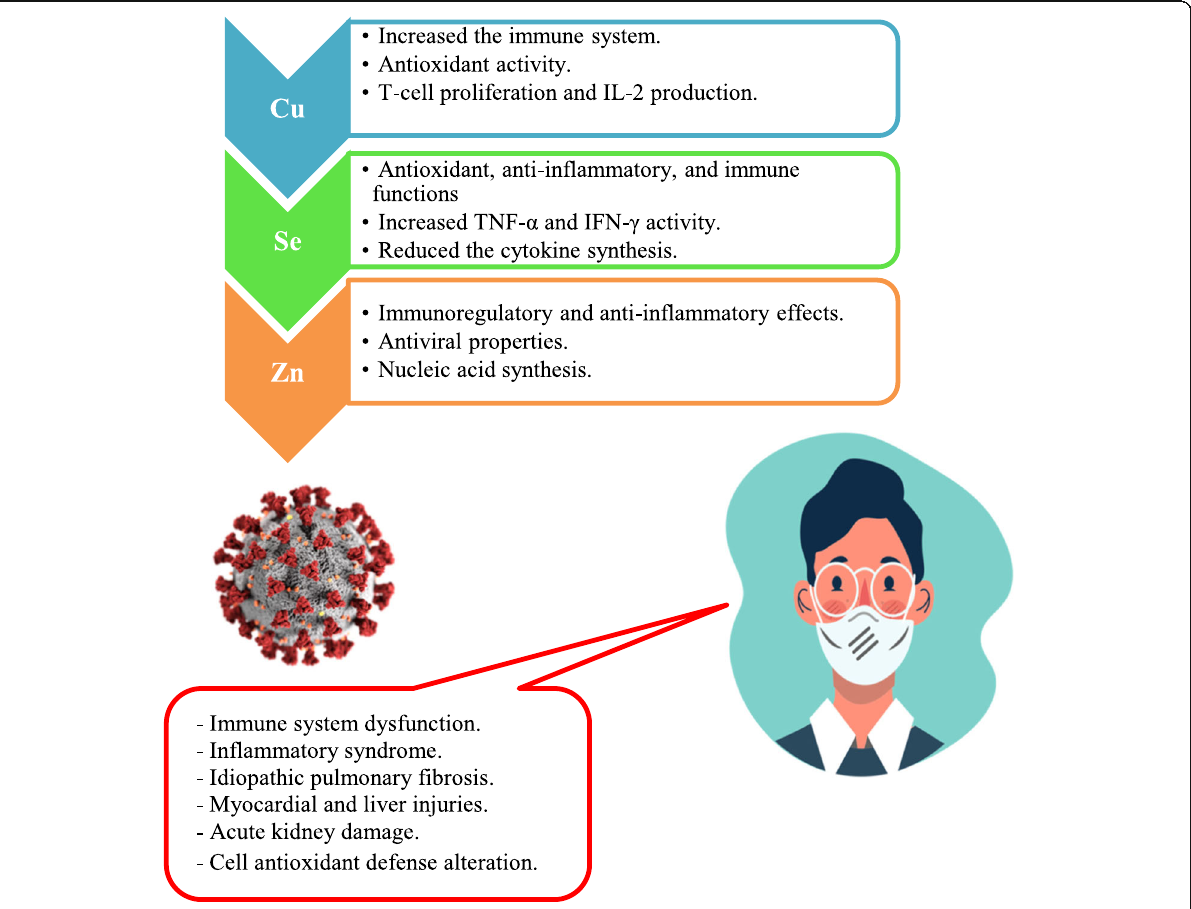
Fig. 1 COVID-19 disorders and potential benefits of Cu, Se, and Zn